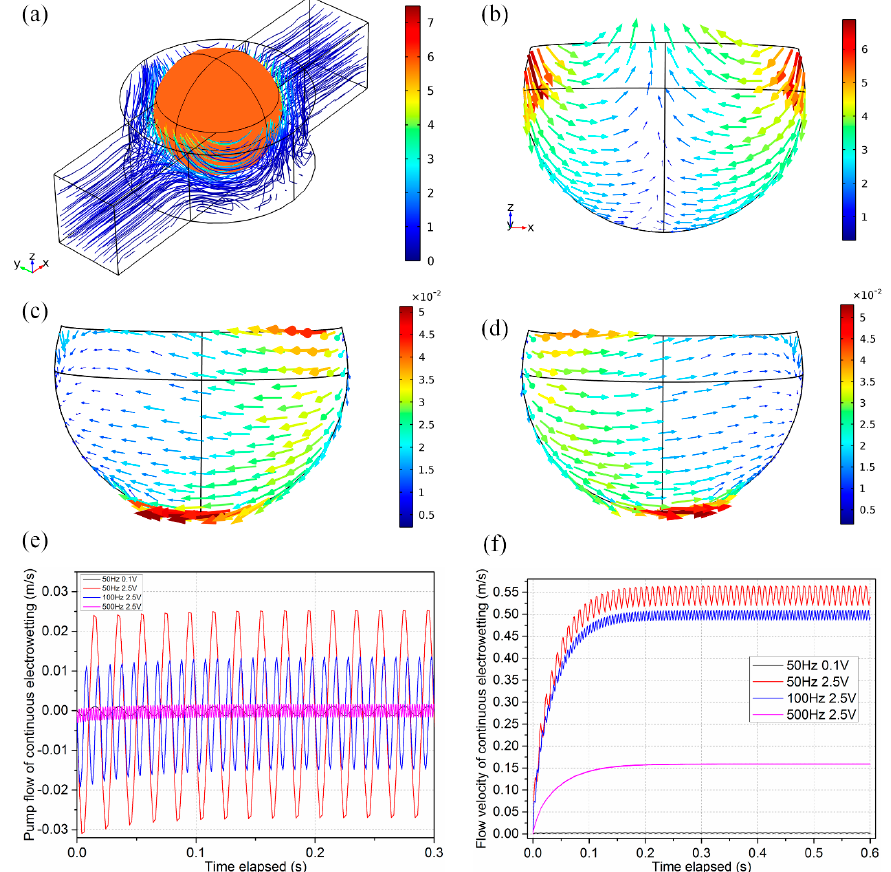
Figure 3. Theoretical quantification of fluid motion caused by metal droplet immersed in electrolyte solution in a background AC electric field. ( a ) Transient flow streamlines at an arbitrary time instant for the typical experimental condition V 0 = 2.5 V, f = 50 Hz, L = 6 mm, E 0 = 416.67 V/m, α ≈ 2.5; ( b ) the dipolar flow pattern at the droplet surface mainly caused by τ local for α ≈ 2.5 at f = 50 Hz and E 0 = 416.67 V/m (2.5 V); ( c , d ) the unidirectional fluid motion induced by τ globe for α ≈ 0.1 at f = 50 Hz and E 0 = 16.67 V/m (0.1 V) is always in the direction of the applied electric field; ( c ) within the first half cycle of AC field with E 0 being along the negative x -direction, the fluid flow is in the negative direction as well; ( d ) within the second half cycle of AC field , both fluid motion and E 0 are along the positive x -direction; ( e ) pump flow component u x and ( f ) total convective flow velocity u generated by AC continuous electrowetting under the condition of various voltage amplitude and field frequency.